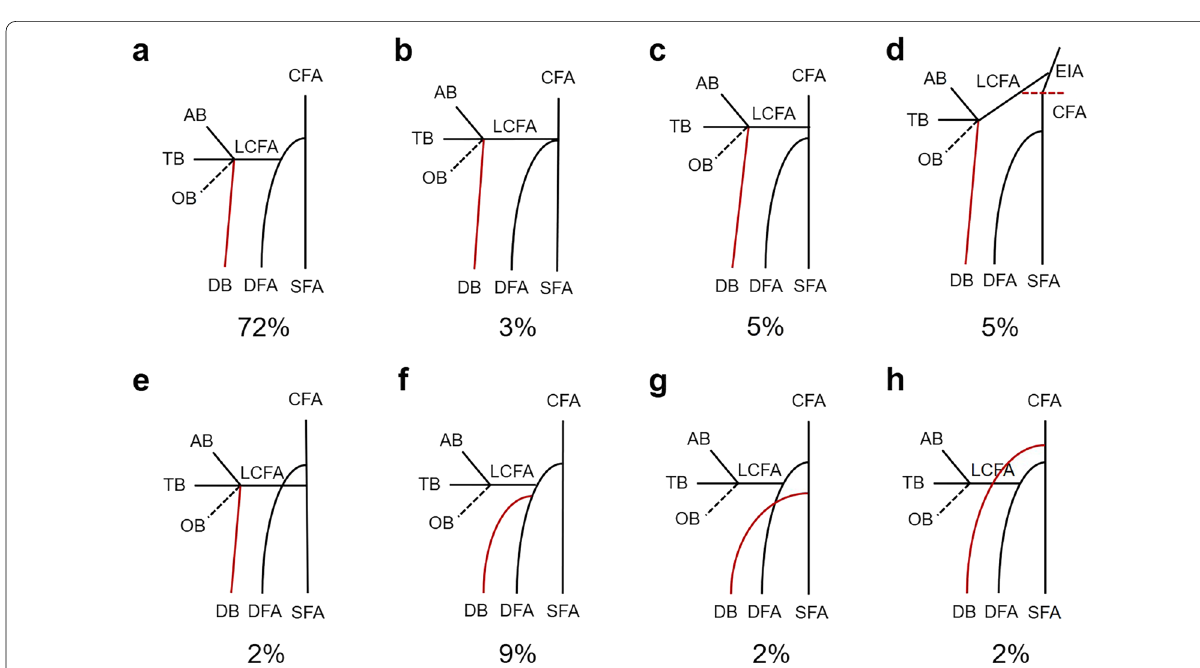
Fig. 3 Different origin variation types and percentages of the descending branch. a–e The descending branch originated from the lateral circumflex femoral artery, while the lateral circumflex femoral artery originated from different superior vessels, such as the deep femoral artery, the common femoral artery, the external iliac artery, and the superficial femoral artery. f The descending branch originated from the deep femoral artery. g The descending branch originated from the superficial femoral artery. h The descending branch originated from the common femoral artery. Notes: Data are presented as %. EIA, external iliac artery; CFA, common femoral artery; SFA, superficial femoral artery; DFA, deep femoral artery; LCFA, lateral circumflex femoral artery; AB, ascending branch; TB, transverse branch; OB, oblique branch; and DB, descending